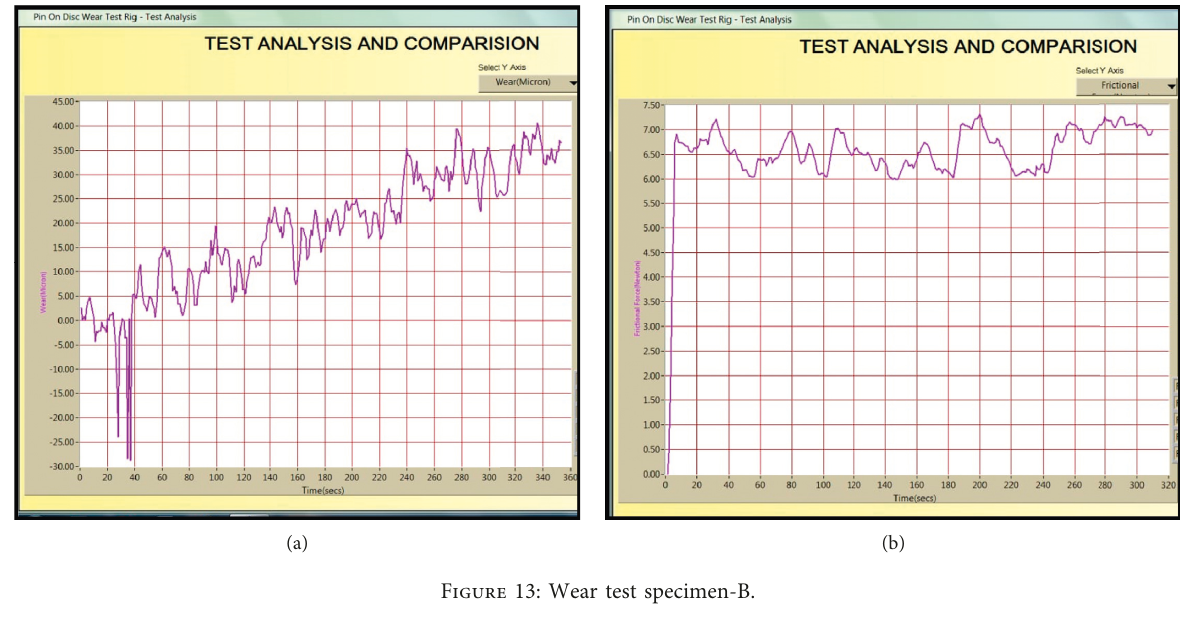
Figure 13: Wear test